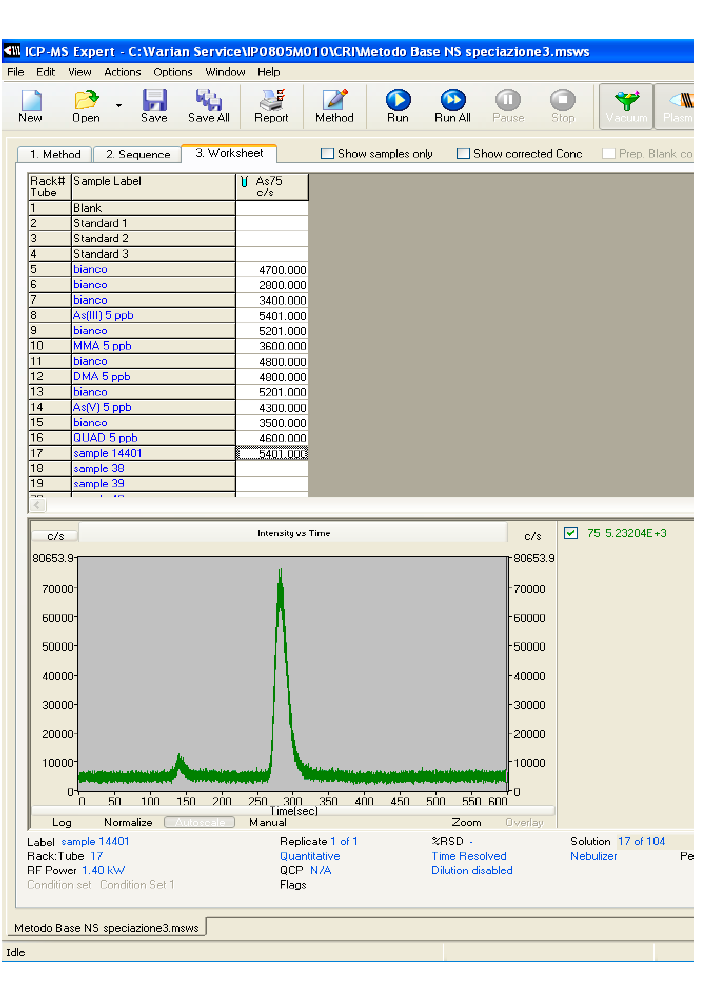
Figure 4. Chromatogram showing the peaks related to the chemical speciation analysis of As for the soil sample coming from the level 4.0–5.0 m of the S53/1D